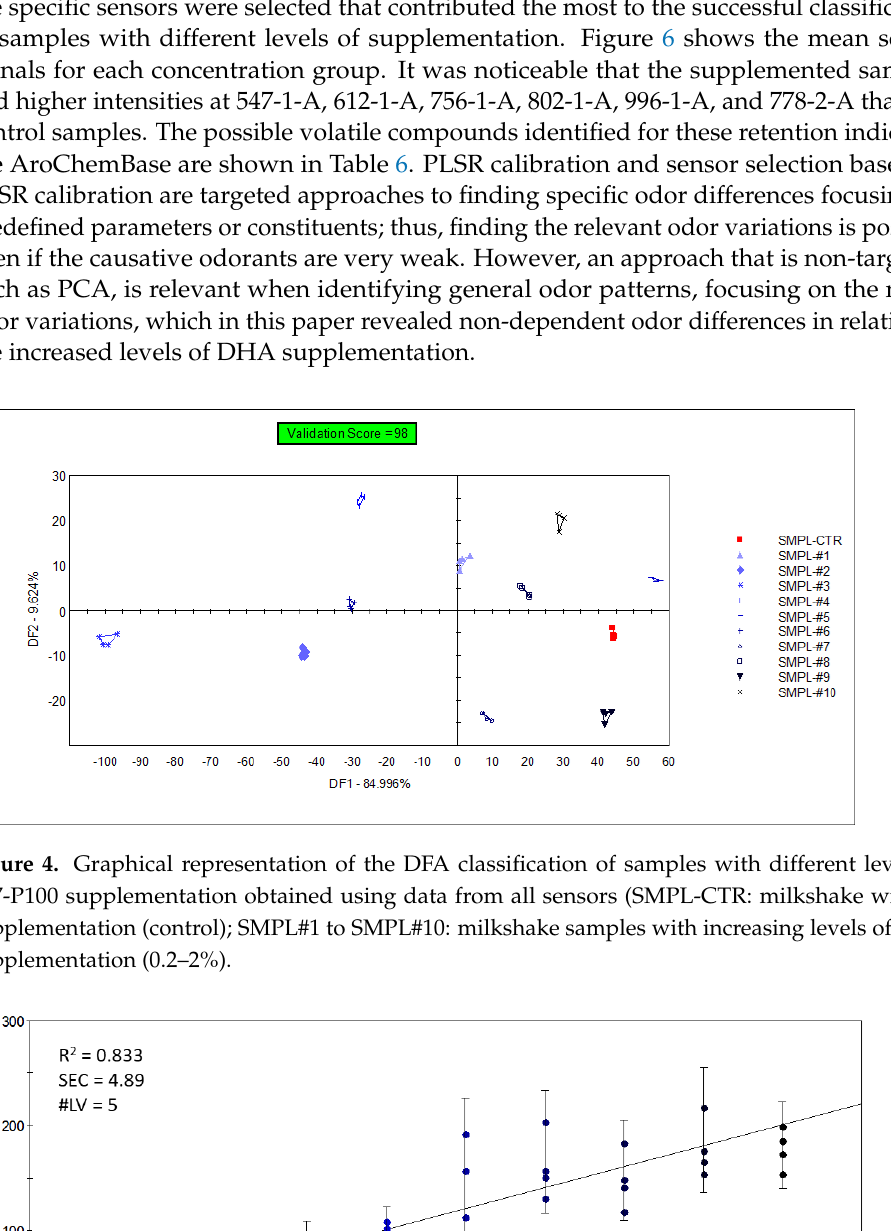
Figure 3. Score plots of PCA performed with data from all sensors, showing the planes of the 1st and 2nd principal components ( a ) and the 3rd and 4th principal components ( b ) (n = 4 repli- cates/sample, SMPL-CTR: milkshake with no supplementation (control); SMPL#1 to SMPL#10: milkshake samples with increasing levels of SP17-100 supplementation (0.2% – 2%).